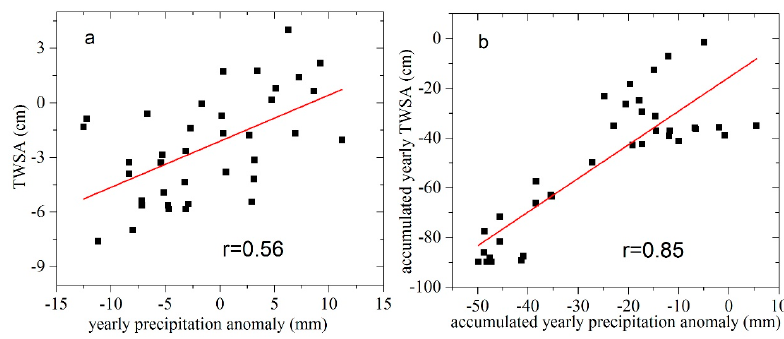
Figure 5. The relationship between precipitation and TWS as evaluated by the Pearson correlation coefficient at the 5% level. ( a ) The relationship between the precipitation anomaly and TWSA (r = 0.56, p < 0.01); ( b ) The relationship between accumulated precipitation anomaly and TWSA (r = 0.85, p < 0.01).